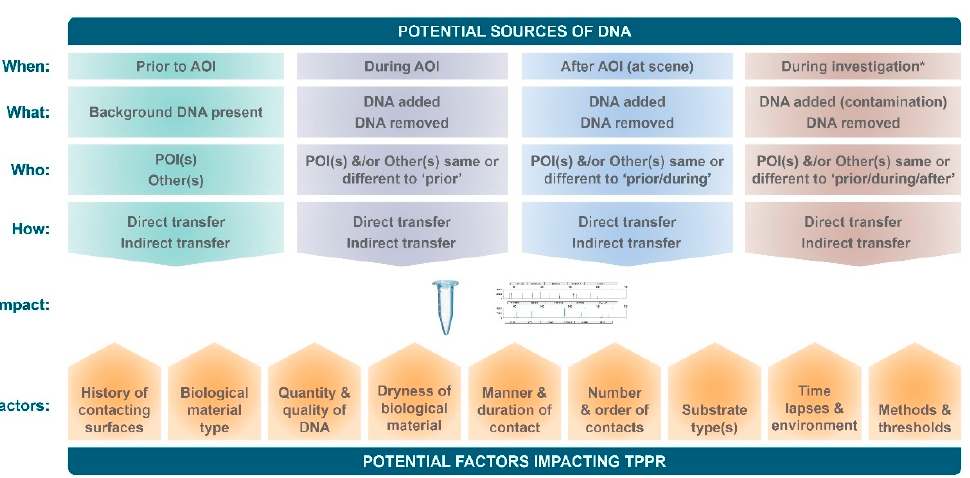
Figure 1. Potential sources contributing to, and factors impacting, the sample recovered and the DNA profile generated from it. The variable shading within each box represents that each source and factor can vary in relative contribution and impact. AOI = Action of Interest. POI = Person of Interest. * Apart from contamination of evidence by DNA from investigators and their associates during the investigation process, detection of AOI-related DNA could be due to cross contamination with another area of the same item or other item of the same case due to direct transfer events (for example, within packaging) or indirect transfer events (for example, via reused, uncleaned, or inadequately cleaned, tools, bench and/or gloves).